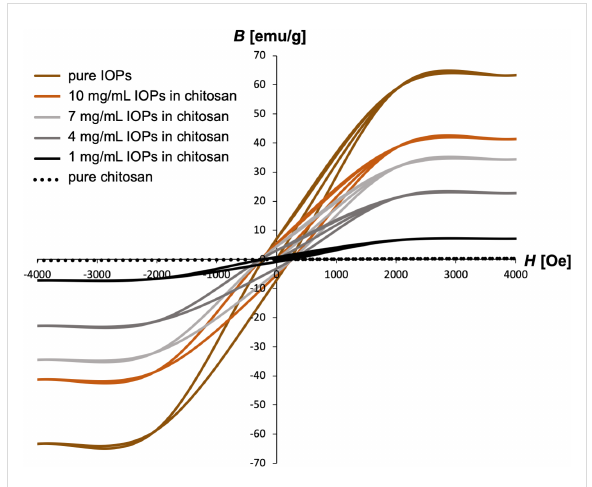
Figure 2: Vibrating sample magnetometer analysis of bare IOPs (brown line), bare chitosan fibers (dashed black line) and chitosan microfibers containing different iron oxide nanoparticle concentrations (10 mg·mL − 1 IOP: orange line, 7 mg·mL − 1 IOP: light gray line, 4 mg·mL − 1 IOP: dark gray line, 1 mg·mL − 1 IOP: black line). The mag- netic saturation of the composite fibers increased with an increase in nanoparticle